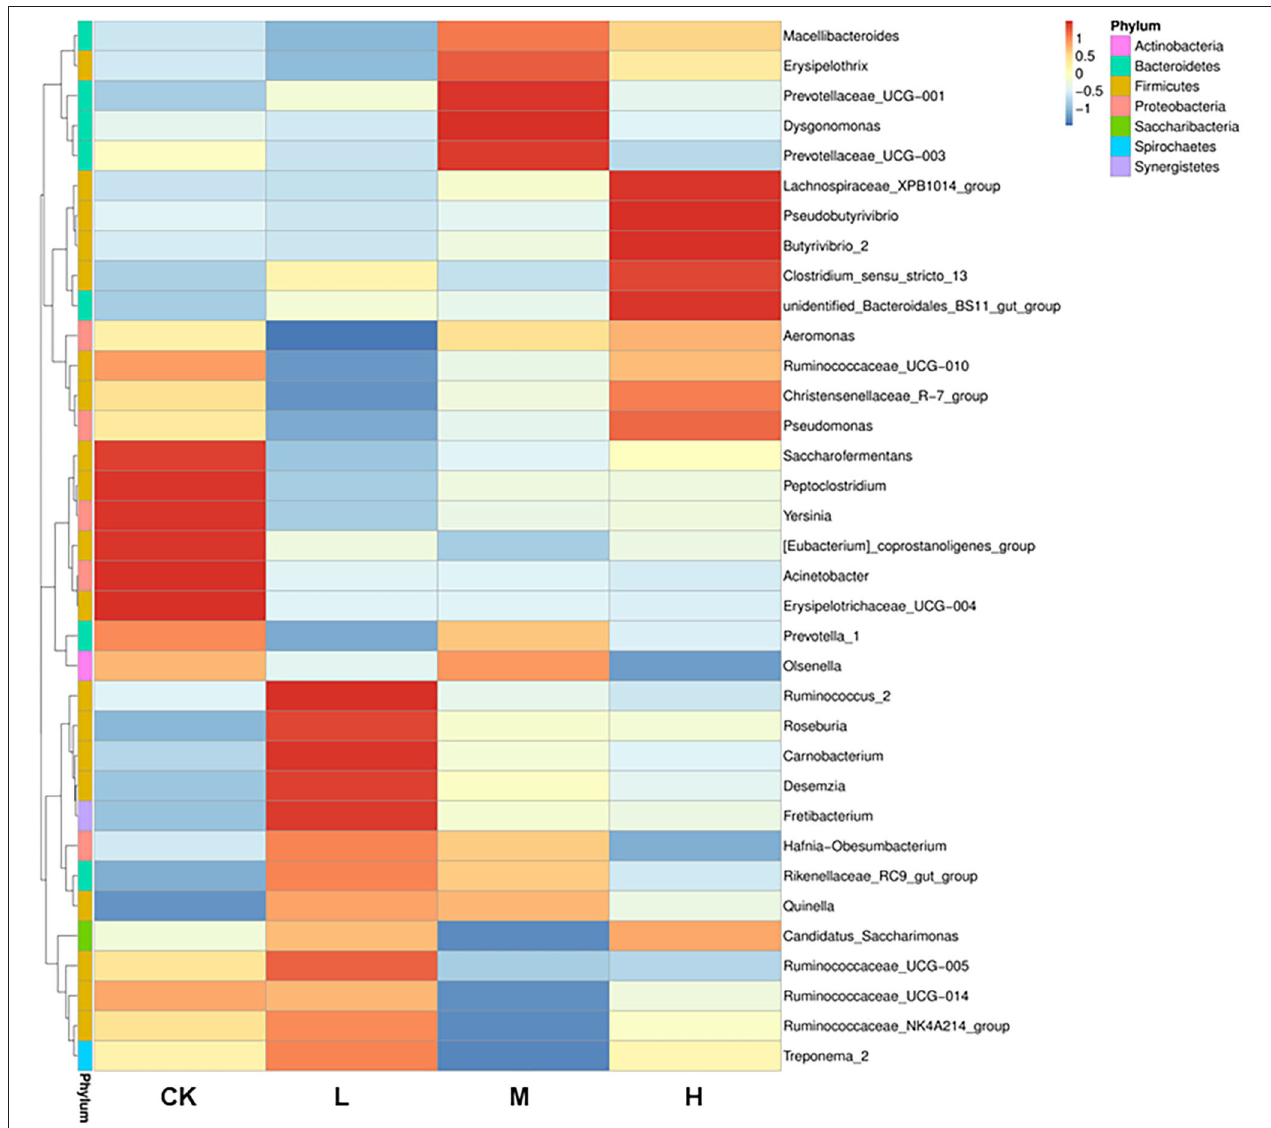
FIGURE 2 | Heatmap analysis of 35 shared prokaryotic community genera of all Tibetan sheep, as determined by the relative abundance of each shared genera through sequencing platform. The vertical direction is the sample information, and the horizontal direction is the species annotation information. The left cluster tree is the species clustering tree; the middle heatmap corresponds to the value of each row of the relative abundance of species after the standardized treatment of the Z